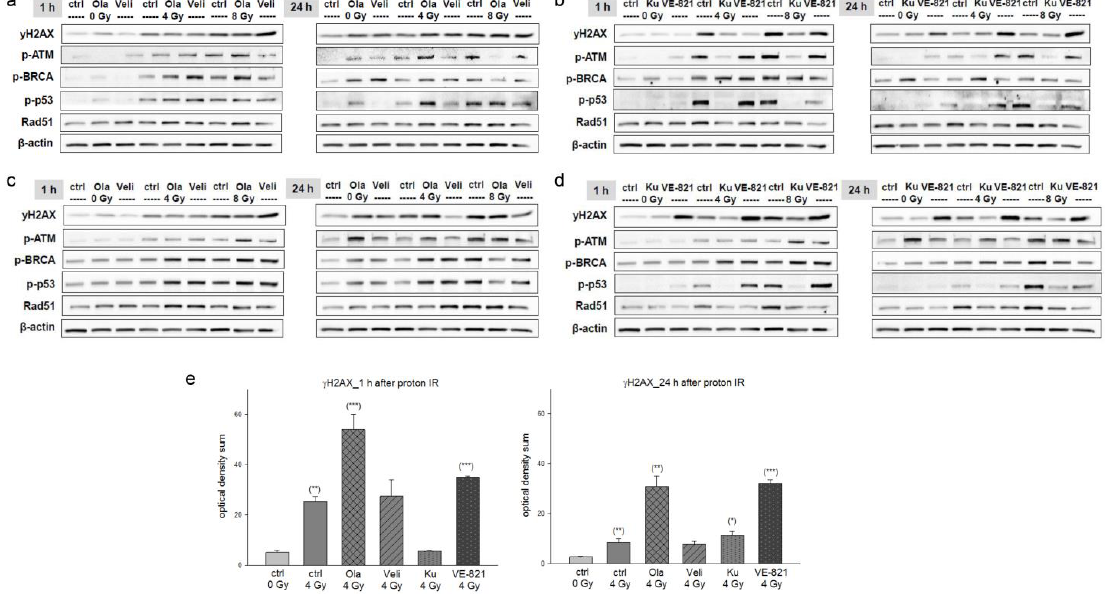
Figure 1. Fractionation experiments with reference X-ray IR under the influence of different types of DNA damage inhibitors. Chemical structures of (a) the PARPi Olaparib and Veliparib, (b) the ATMi Ku-55933, and (c) the ATRi VE-821. Cell growth of two chondrosarcoma cell lines SW-1353 and Cal78 was inhibited in a dose-dependent manner by combined treatment of 2.5, 10, or 25 µM inhibitor and X-ray IR (mean ± SD, n = 3, measured in biological quadruplicates). Statistical significances are defined as follows: * p < 0.05; ** p < 0.01; *** p < 0.001. IR regimes were 0 Gy (non-IR control; dark gray), fractionated IR of 8 Gy on three subsequent days (dashed), and the total dose of 24 Gy (dotted). Viability was measured 24 h after IR. VE-821 showed the most efficient response. The dose-dependent reduction in viability is observed with all inhibitors, whereas VE-821 has the most efficient response. Large differences between the individual IR re- gimes could not be observed.